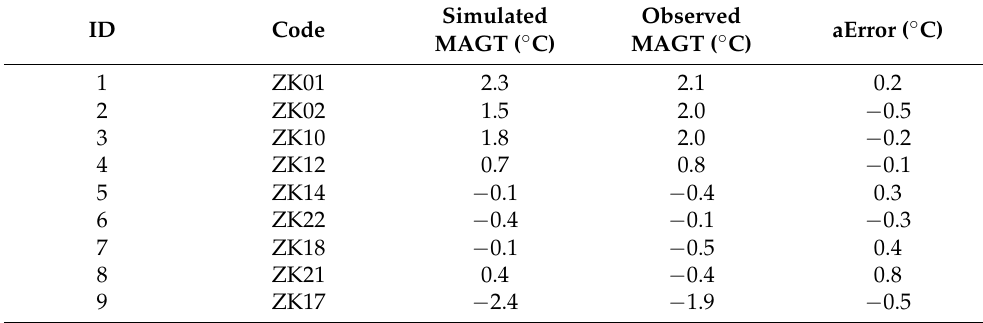
Table 3. Simulated and observed mean annual ground temperature (MAGT) of the nine representative boreholes in the Gaize area.